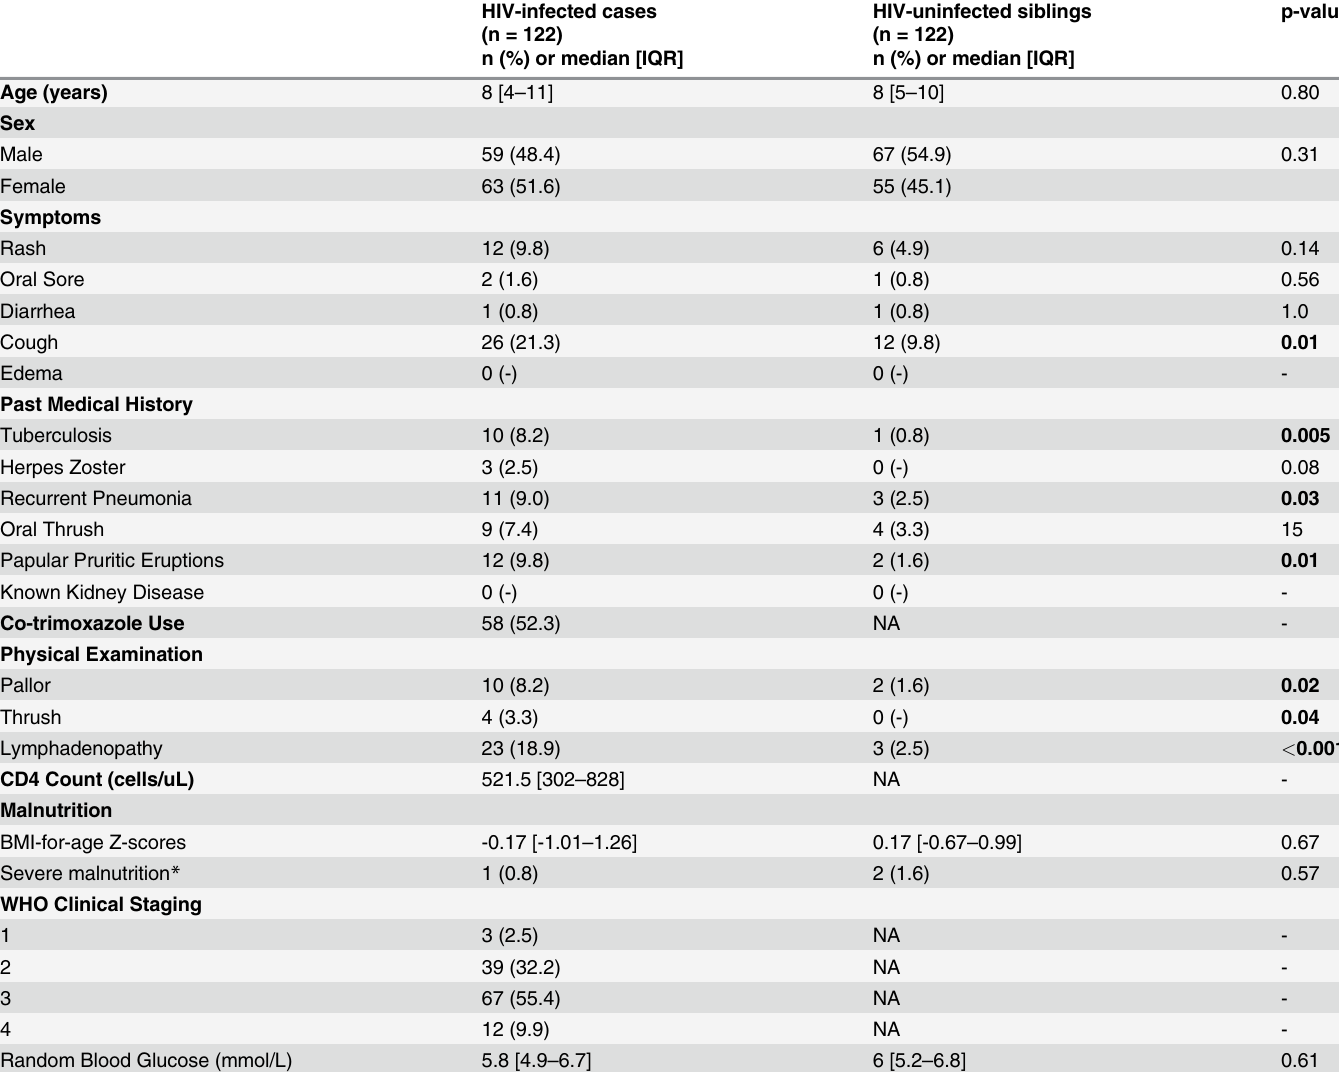
Table 1. Baseline characteristics of HIV-infected children and HIV-uninfected